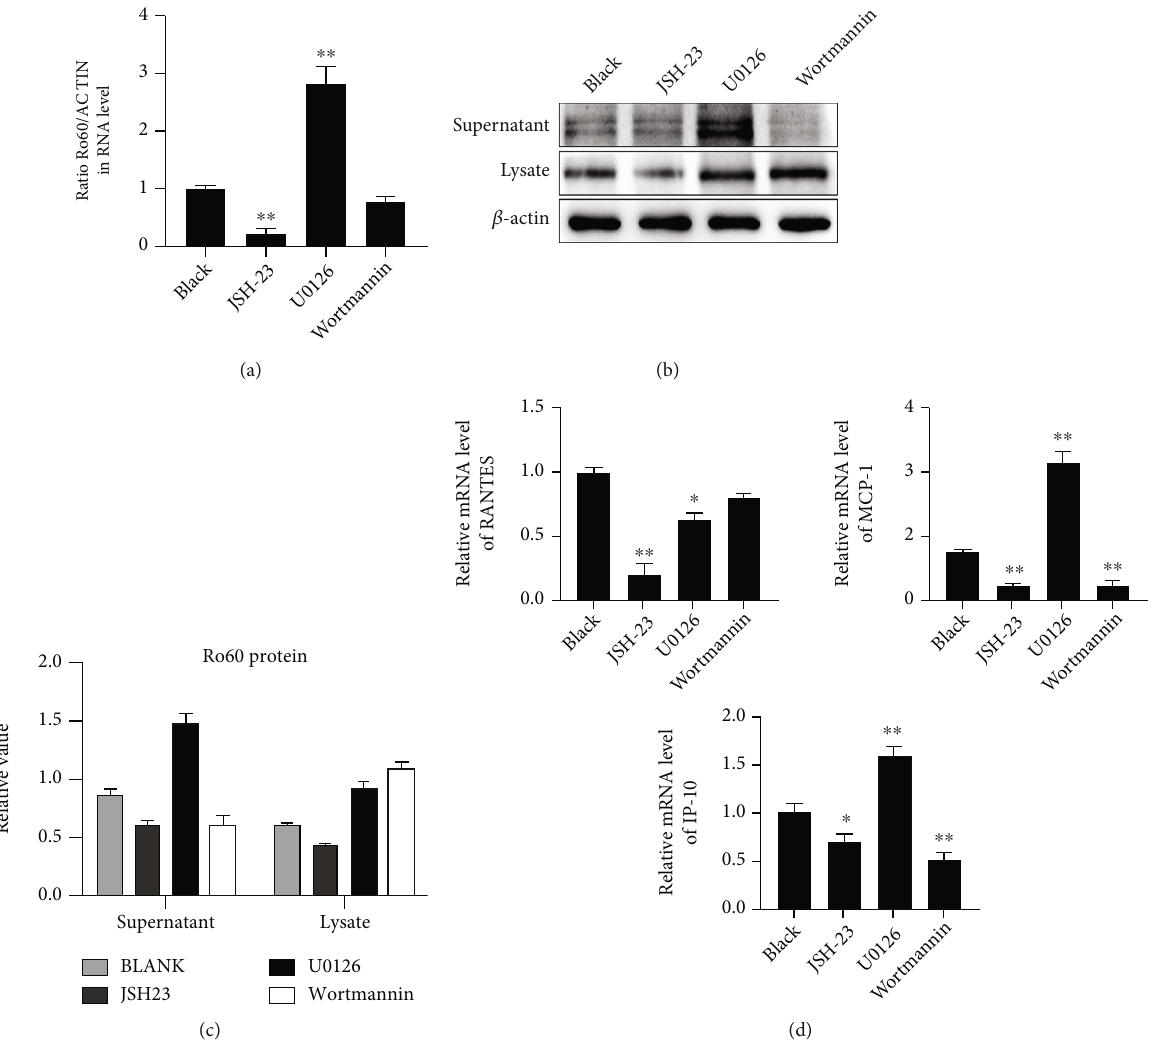
Figure 3: Inhibition of the PI3K/Akt and NF- κ B Axis a ff ects the regulation of Ro60 and proin fl ammatory cytokines by IL-33/ST2 in KCs. PAM212 cells cultured in vitro were treated with ultraviolet B irradiation and IL-33 stimulation. (a) qRT-PCR determination of Ro60 mRNA expression in di ff erent treatment groups. (b) Western blotting determination of Ro60 protein expression in supernatants and cell lysates in di ff erent treatment groups. (c) Densitometry analysis of Western blot bands. (d) qRT-PCR detection of RANTES, MCP-1, and IP-10 mRNA levels in KCs. Data were obtained from three experiments conducted independently. Data points and error bars denote mean ± SEM . ∗ p < 0 : 05 , ∗∗ p < 0 : 01 . KC: